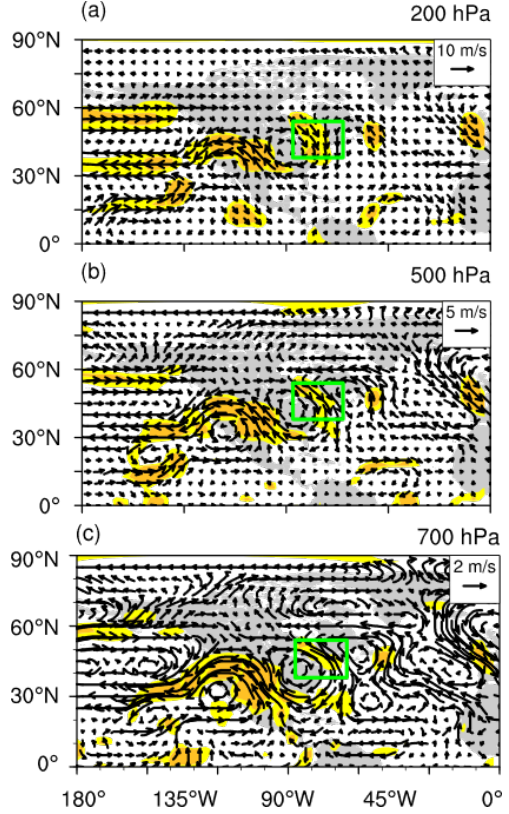
Figure 5. Composite differences in April wind (vectors, m/s; from NCEP-2) between positive and negative ASO anomaly events at ( a ) 200 hPa, ( b ) 500 hPa, and ( c ) 700 hPa. Light and dark yellow areas represent values that are statistically significant at the 90% and 95% confidence levels, respectively. Detailed anomalous events can be found in Table 1.